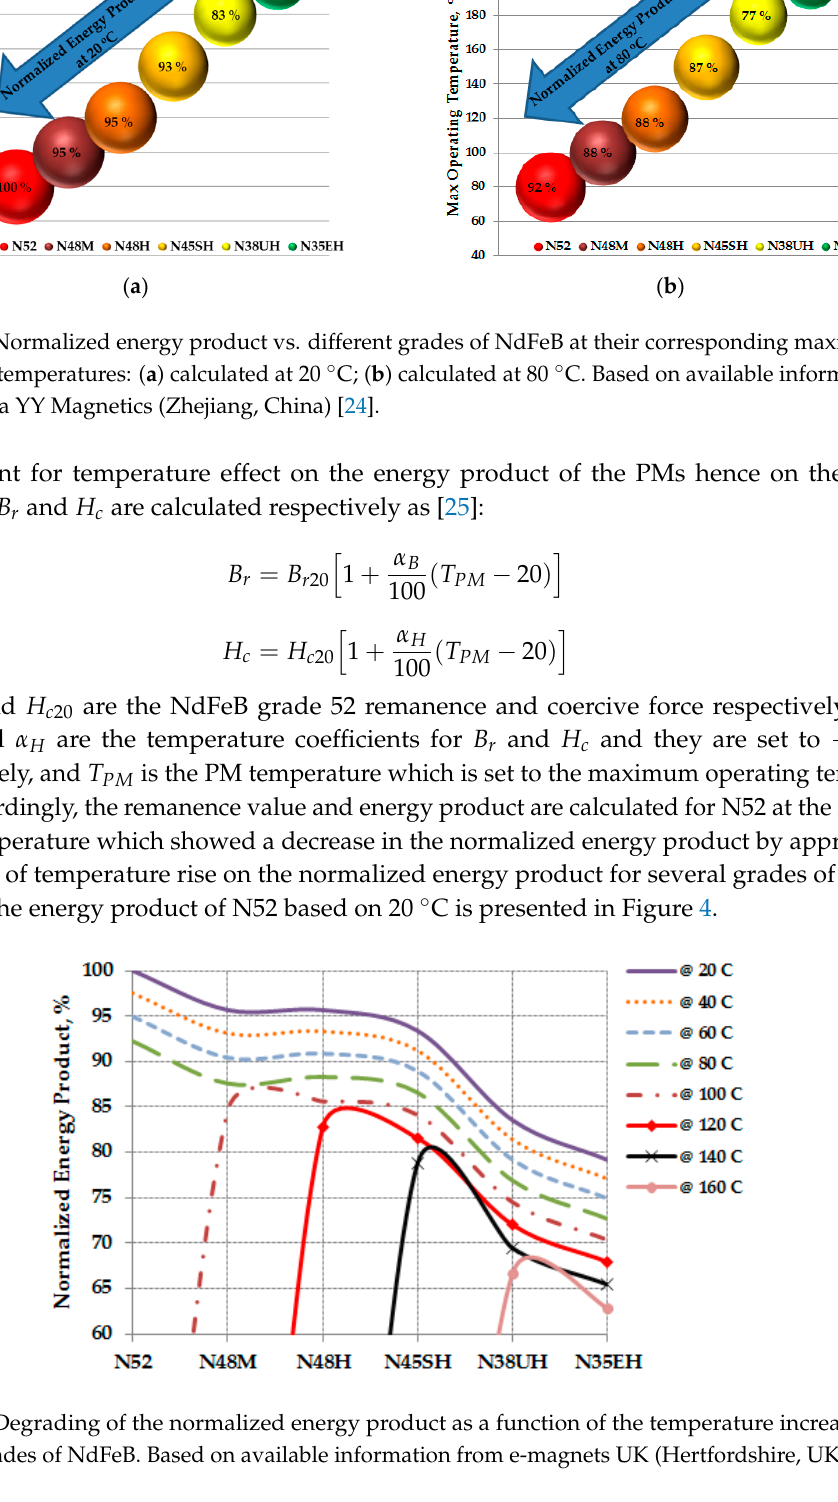
Figure 3. Normalized energy product vs. different grades of NdFeB at their corresponding maximum operating temperatures: ( a ) calculated at 20 °C; ( b ) calculated at 80 °C. Based on available information from China YY Magnetics (Zhejiang, China) [24].